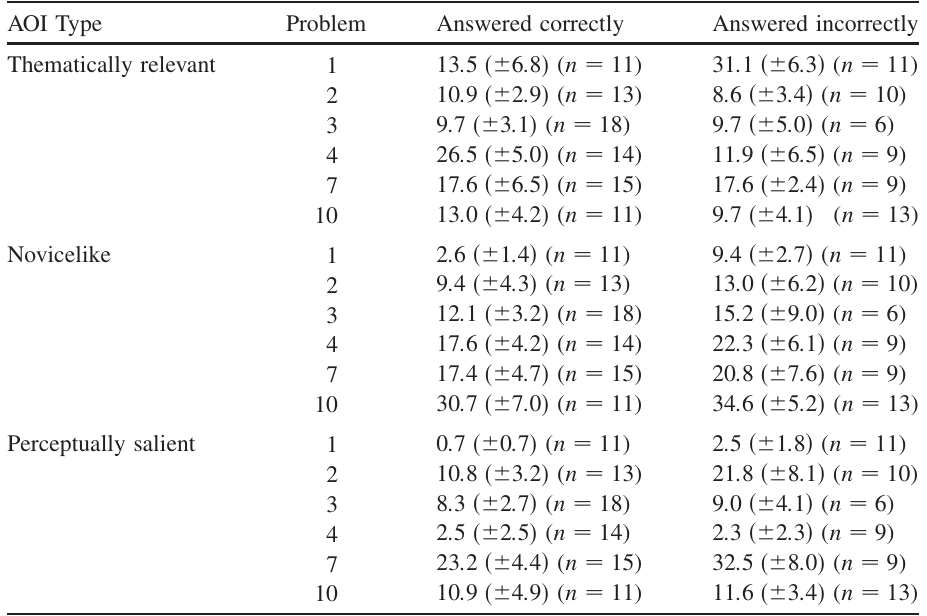
TABLE VI. Mean percentage fixation time spent ( (cid:4) standard error) during the first 2 sec after leaving the problem statement for thematically relevant, novicelike, and perceptually salient AOIs for participants who answered the question correctly or incorrectly AOI